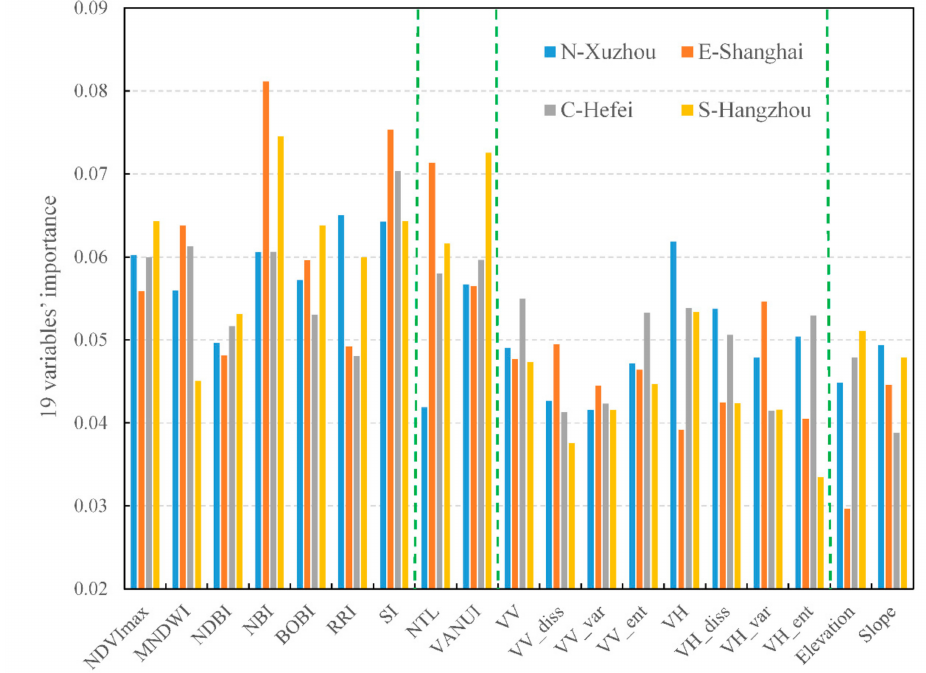
Figure 6. Importance of the input features derived from the random forest model using the training samples in four training municipal districts. N-Xuzhou, E-Shanghai, C-Hefei, and S-Hangzhou represent Xuzhou in Northern Plains, Shanghai in East Coast, Hefei in Central Hills, and Hangzhou in Southern Mountain,